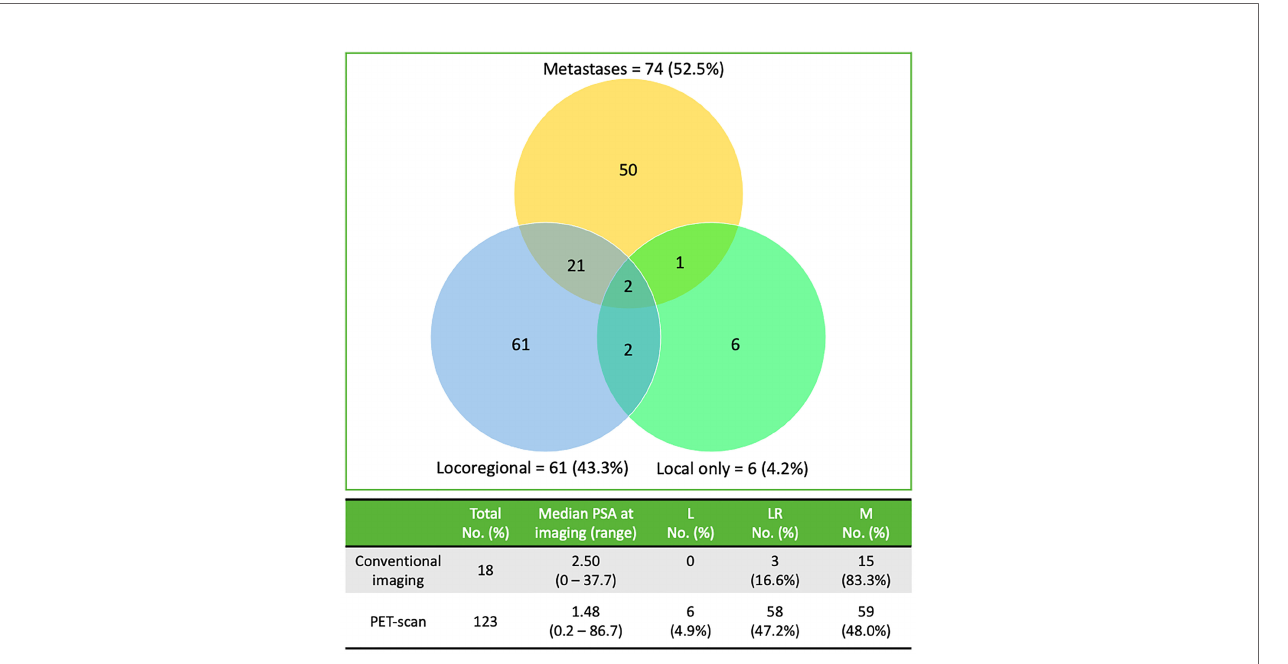
FIGURE 2 | Venn diagram of radiologically patterns of failures ’ distribution for the 141 patients and imaging tools (conventional imaging vs PET) used to detect recurrence location. Lesions are categorized as local only (disease within the region of the PB), locoregional (de fi ned as the presence of pelvic LN ± PB) or metastatic failure (at least one distant lesion outside the pelvis ± locoregional disease). LN, Lymph Nodes; PET, positron-emission tomography.